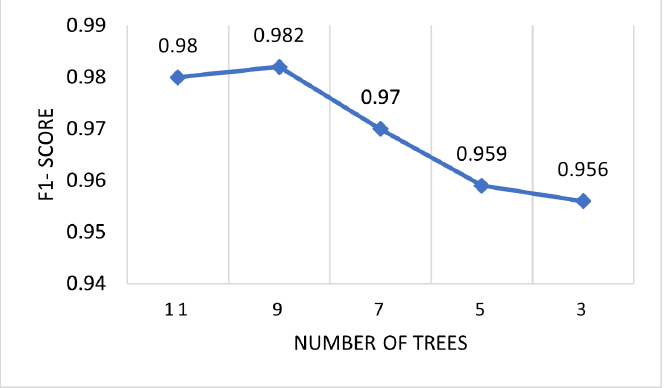
Figure 4. Performance variations with a different number of trees in random forest.